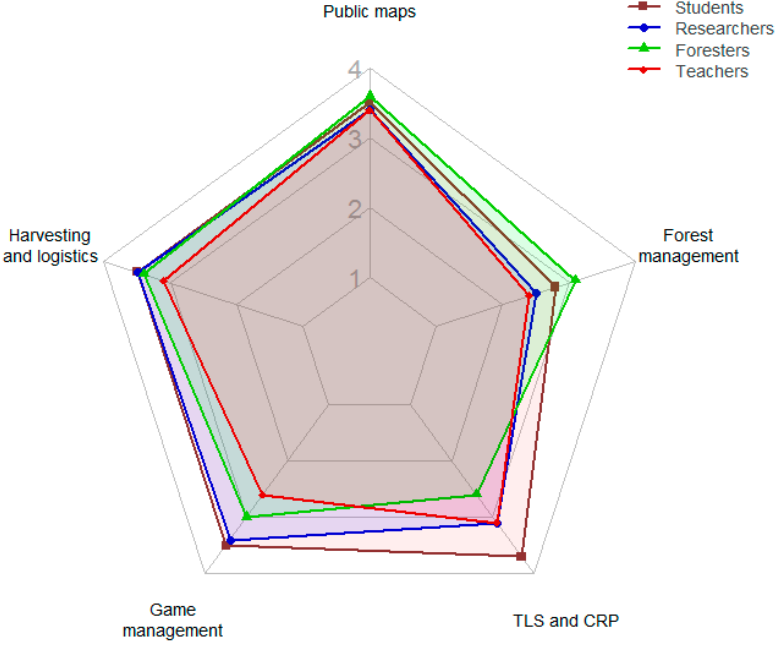
Figure 2. Importance of the web mapping applications (1—very low importance, 4—very high